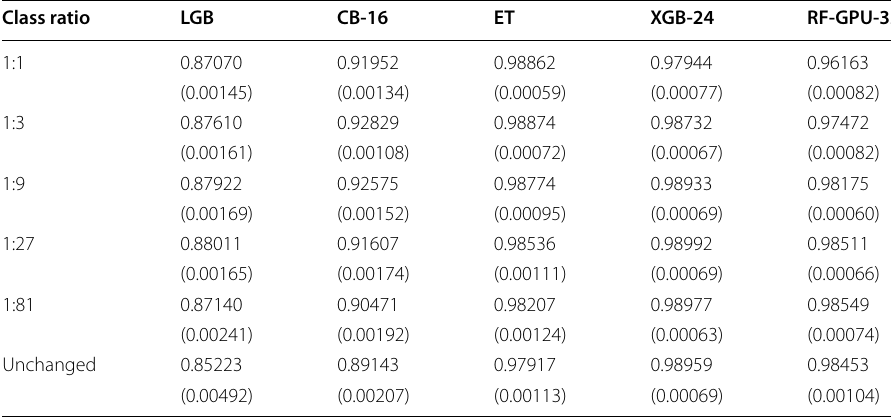
Table 5 DMEPOS mean and standard deviation of AUC with varying levels of RUS (10 iterations of fivefold